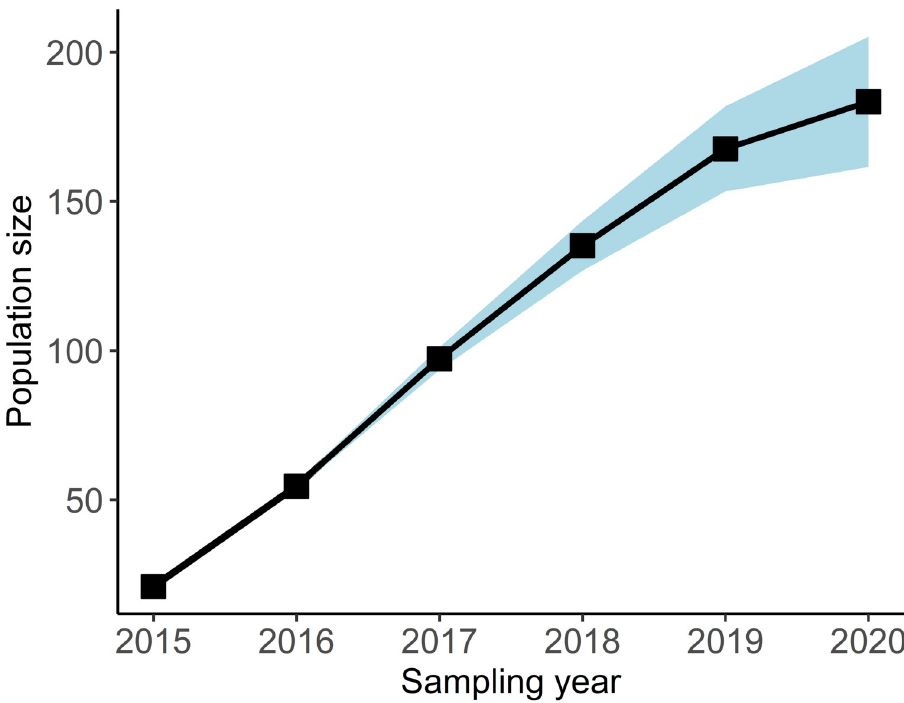
Fig 4. Population size of headstarted Blanding’s Turtles in the Rouge National Urban Park estimated using the Jolly-Seber open population model. The blue shading indicates the 95% confidence interval for population size.